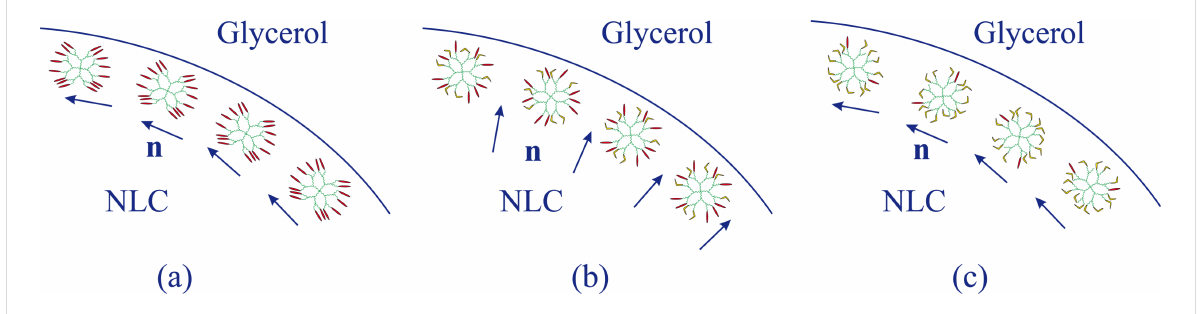
Figure 4: Schematic illustration of dendrimer molecules near the NLC–glycerol interface and of the NLC director n (a) when all azo moieties of the dendrimer are in trans state, (b) when the concentration of trans isomers is comparable to the concentration of cis isomers, (c) when almost all isomers exist in the cis